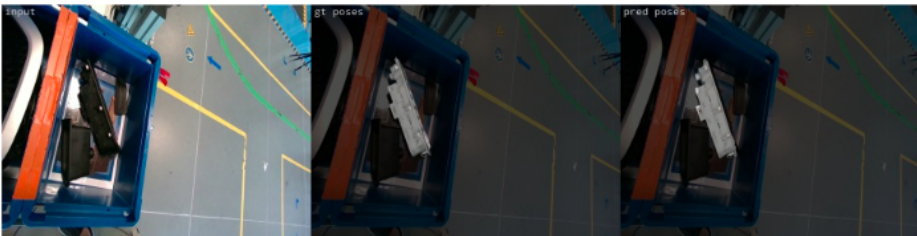
Figure 18. Examples of precise predictions on validation images from the real industrial environment. The first column presents the input validation image, the second column the ground truth, and the third one the estimated object pose.